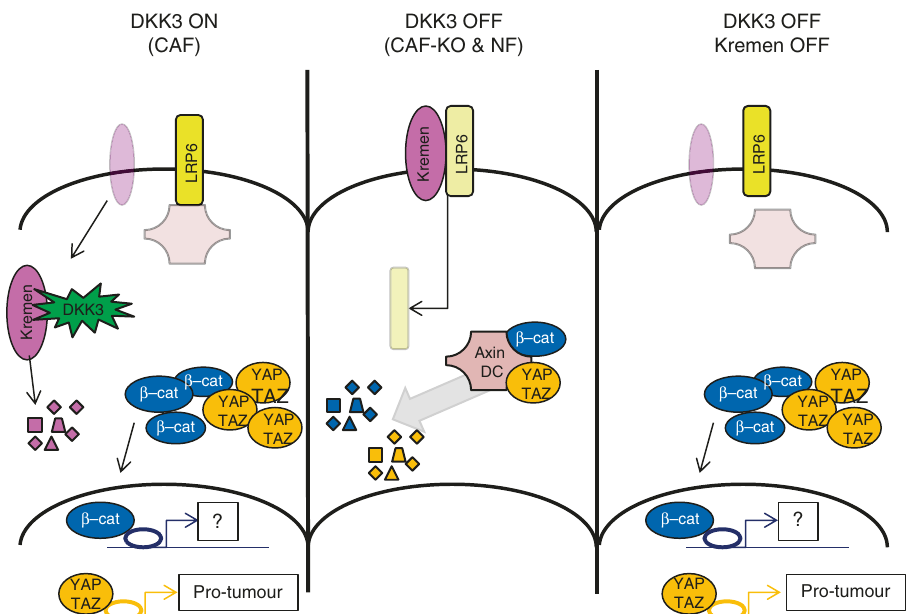
Fig. 9 Model depicting the proposed mechanism of DKK3-mediated regulation of YAP/TAZ and β -catenin in CAFs. On CAFs, DKK3 destabilises Wnt negative regulator Kremen leading to increased LRP6 membrane localisation, which in turn stabilises YAP/TAZ and β -catenin levels via canonical Wnt. Whereas β -catenin signalling is dispensable for CAFs to remodel the ECM and promote cancer cell growth and invasion, DKK3-driven YAP activation is required to induce a tumour-promoting phenotype. Absence of DKK3 in DKK3-null CAFs and NFs is associated with decreased YAP/TAZ and β -catenin activity. In CAFs, loss of DKK3 leads to concomitant upregulation of Kremen, LRP6 inactivation and YAP/TAZ and β -catenin destabilization. In